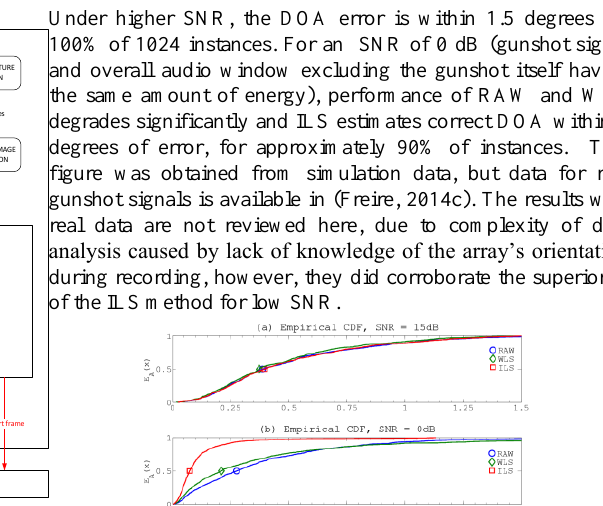
Figure 5. DFD of the MOSA System.